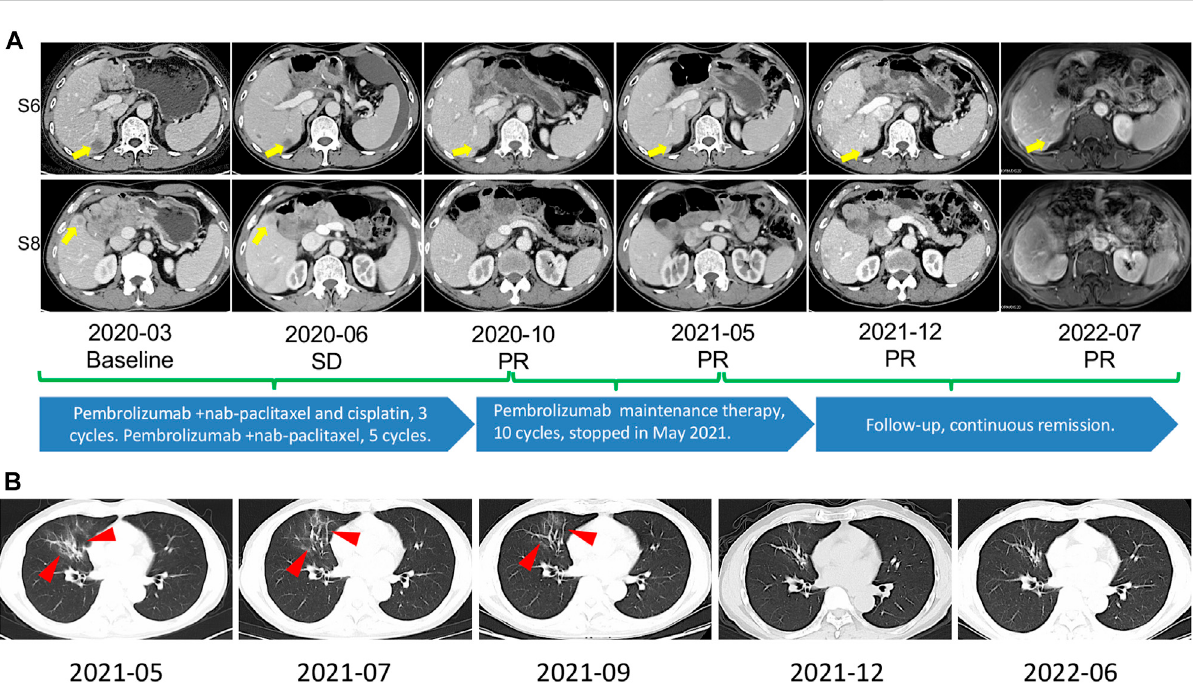
FIGURE 1 (A) The timeline and representative CT and MRI images. CT of March 2020, yellow arrow points toward intrahepatic lesions in S6/S8 at tumor metastasis. CT of June 2020 revealed stable disease was observed after 2 cycles of nab-paclitaxel/cisplatin plus pembrolizumab. CT of October 2020, partial remission was observed after 3 cycles of nab-paclitaxel/cisplatin plus pembrolizumab and 5 cycles of nab-paclitaxel plus pembrolizumab. CT of May 2021, continuous partial remission was observed after 10 cycles of pembrolizumab maintenance therapy. In July 2022, MRI showed durable partial remission. S6, Segment 6; S8, Segment 8; SD, stable disease; PR, partial remission. (B) Image changes during prednisolone treatment after the onset of CIP. CIP was signi fi cantly relieved, as seen in the images. The red arrow points to the part where CIP occurred. CIP, checkpoint inhibitor